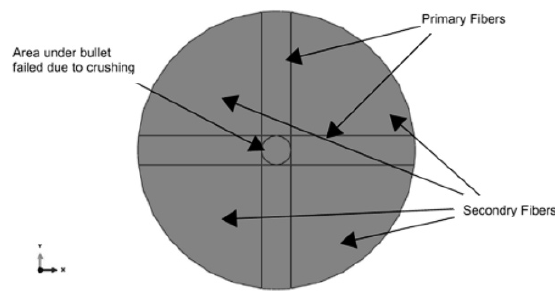
Figure 16. Primary and secondary fibers in cone formed on back face of